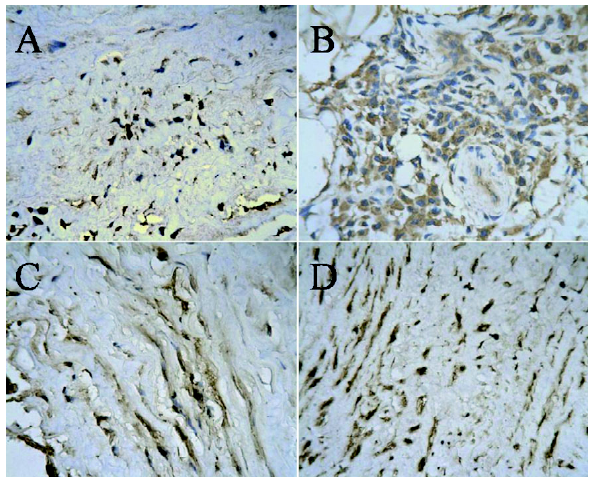
Fig. 10 - In the aortic media, the expression of osteopontin was weak in the aortic dissection (A), intense positive in aortic aneurysm (B), focal positive in the coronary artery disease (C), but evenly positive in healthy control (D). The intense of the expressions in a descending order was aortic aneurysm > healthy control > coronary heart disease > aortic dissection. Envision×400